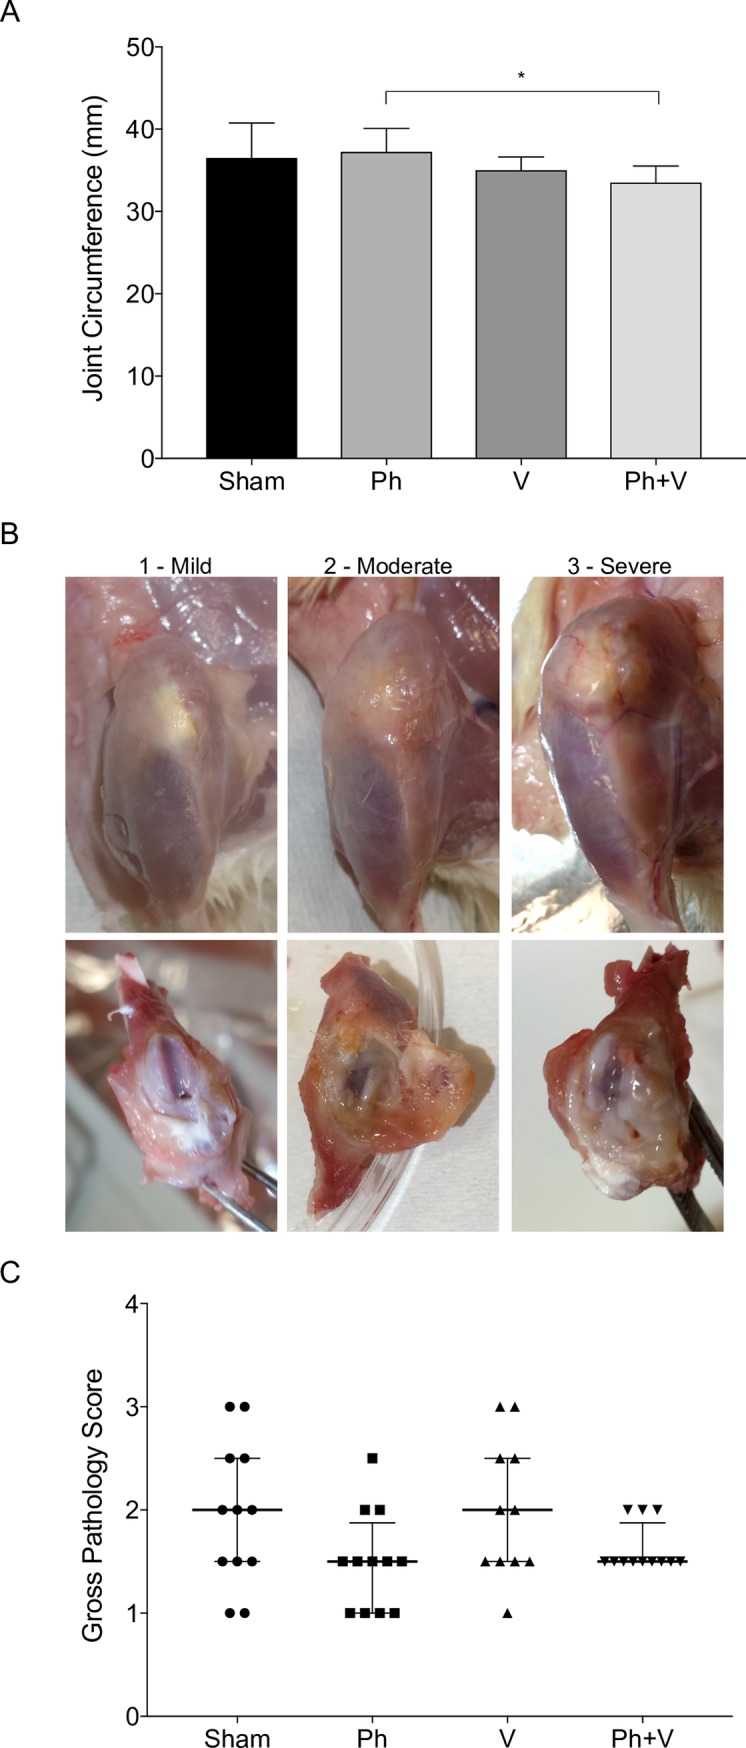
Joint swelling and pathology.A) Joint circumference of the operated (implant) limb of infected and sham-treated (Sham, n = 12), and those treated with phage alone (Ph, n = 12), vancomycin alone (V, n = 11) and phage plus vancomycin (Ph+V, n = 12) at day 28 post-surgery. Data shows mean ± SD. *P < 0.05 B. Representative images of mild (1), moderate (2) and severe (3) joint pathology changes in the operated hind limb of infected animals at day 28 post-surgery. Based on this scoring system, C) gross joint pathology scores were compared for sham-treated (Sham), and those treated with phage alone (Ph), vancomycin alone (V) and phage plus vancomycin (Ph+V) at day 28 post-surgery (7 days after commencement of treatment). Data shows median ± interquartile range.